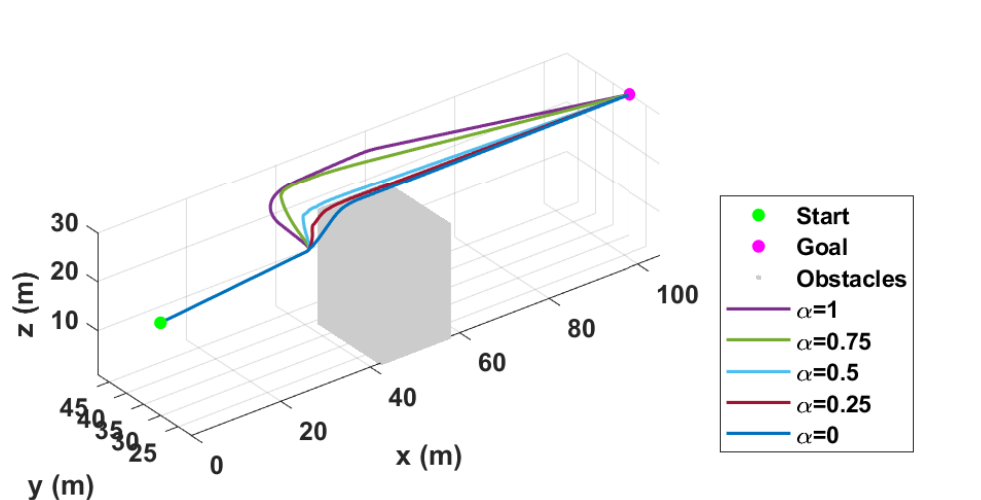
Figure 6. 3D trajectories in accordance with α